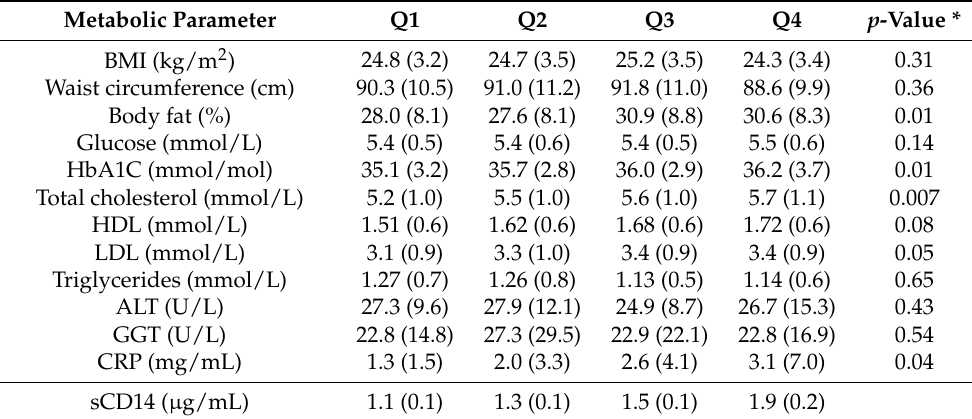
Table 7. The quartile analyses for sCD14 including all individuals ( n =